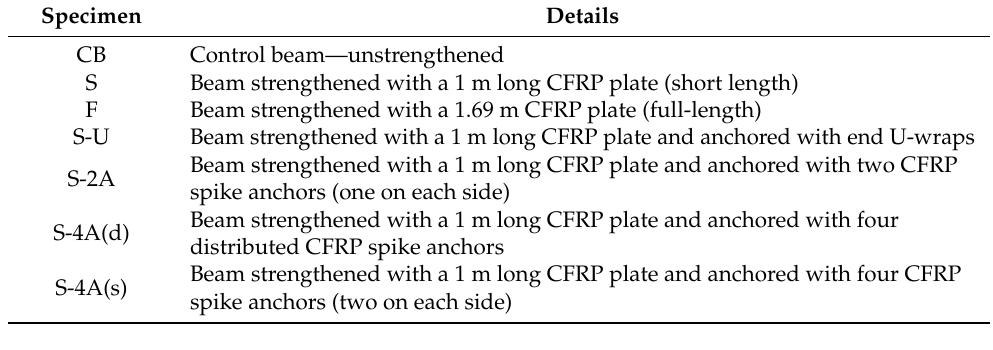
Table 1. Details of the tested specimens.